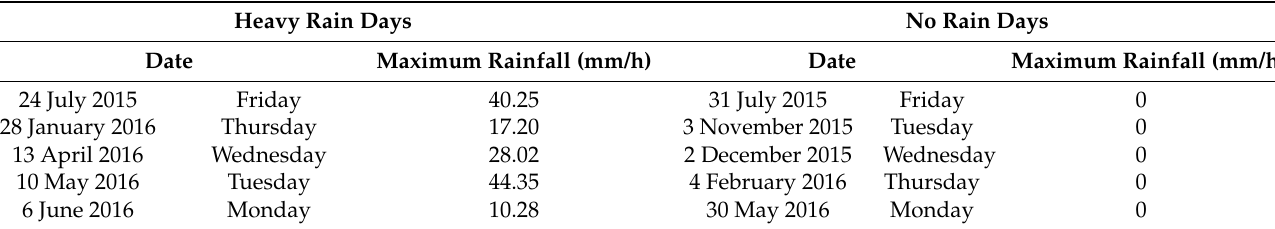
Table 2. The selected rainfall